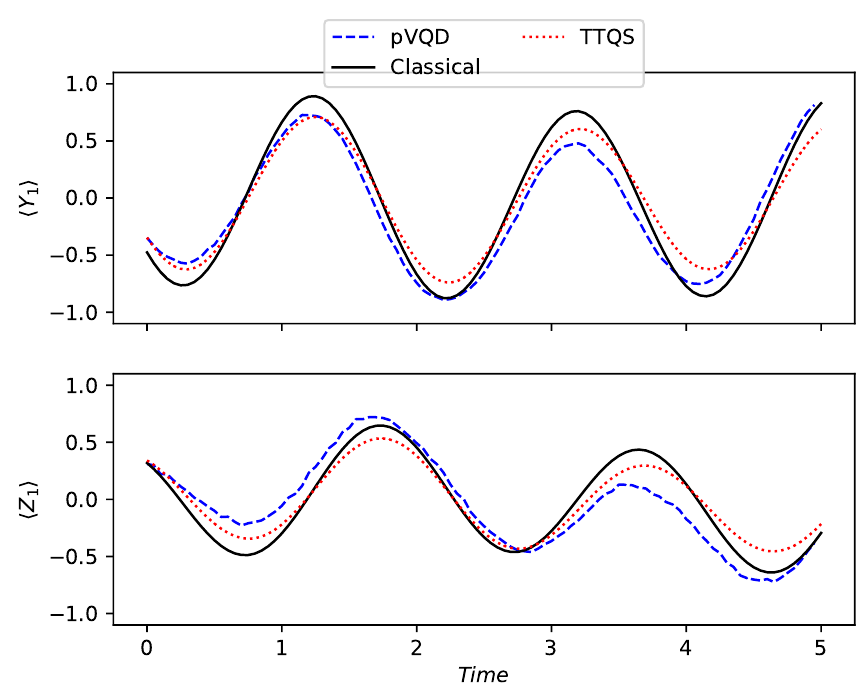
Figure 4: Time evolution of TQS and pVQD on a 2 qubit state, with Hamiltonian H , simulated with a noisy simulator. The noise model was taken from the IBM TFI ,2 Quantum Experience provider, mimicking the noise of the real quantum processor ibmq_bogota . pVQD was run for 100 optimization steps, and made use of a paramet- ric quantum circuit with 8 parameters, made out of successive layers of single qubit X rotations and 2-qubit ZZ rotations. The expectation values of 〈 Y